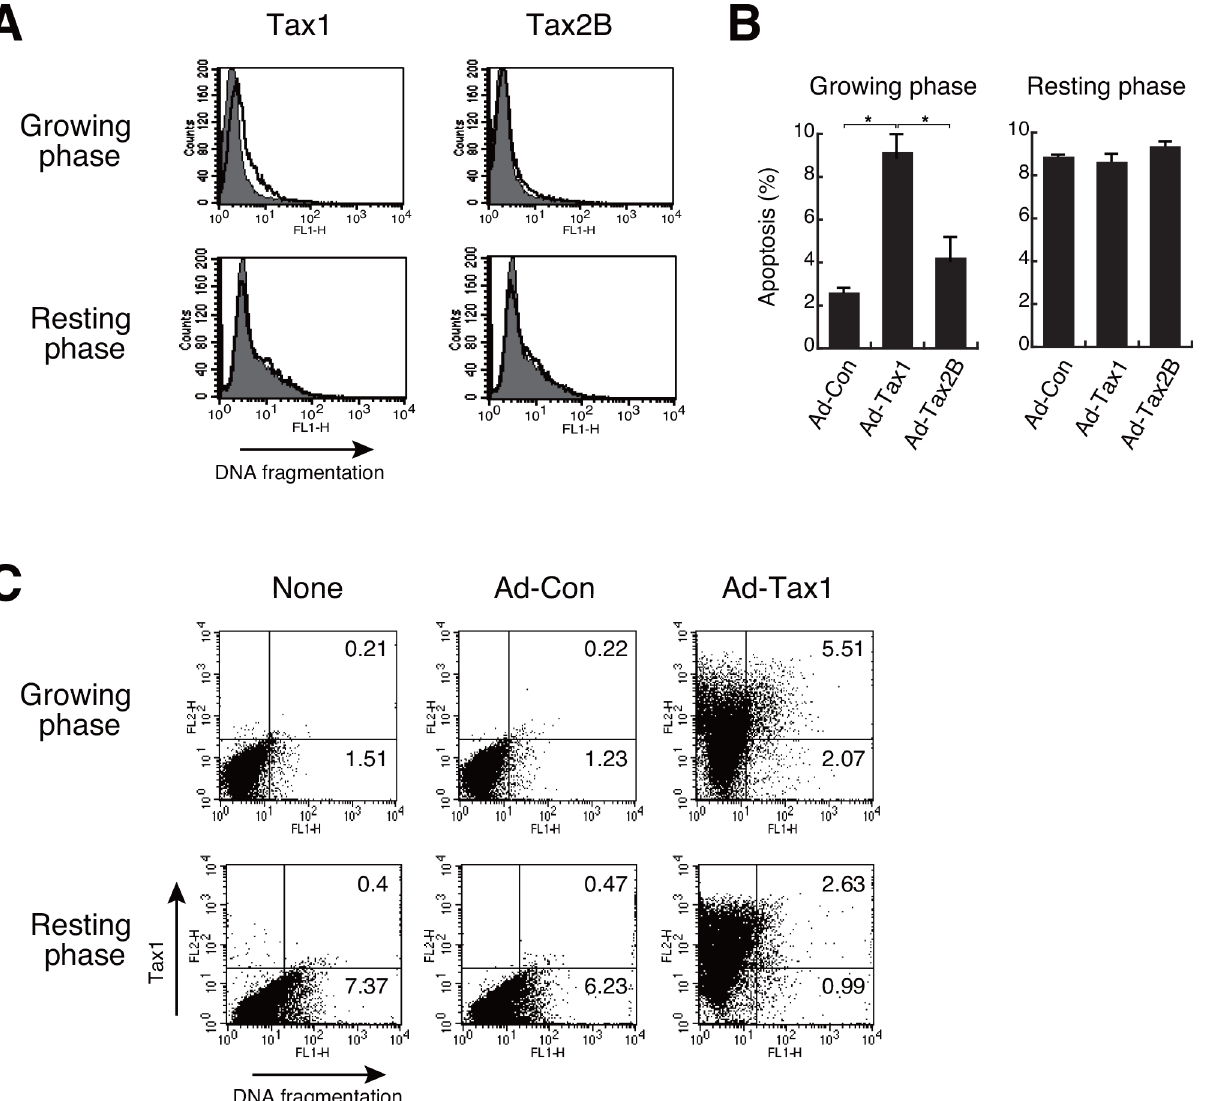
Fig 4. Induction of apoptosis by Tax1 in growing cells. (A) Growing or resting Kit 225 cells were infected with Ad-Tax1 or Ad-Tax2B, and cultured for 72 h. DNA fragmentation was detected by the TUNEL assay using a flow cytometer. The thick line and gray area indicate Ad-Tax1- or Ad-Tax2B-treated cells and Ad-Con-treated cells, respectively. (B) Percentage averages number of the cells undergoing apoptosis was calculated from three independent experiments. Values are shown as the means ± SE. * , p < 0.05. (C) DNA fragmentation and Tax1 expression were measured using a flow cytometer. Tax1 was